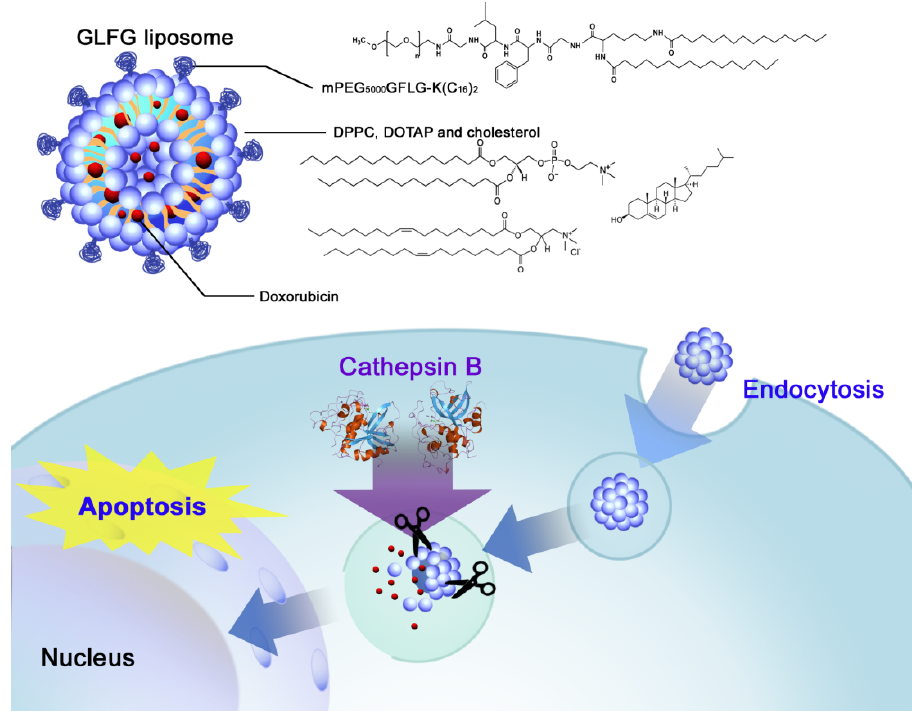
Figure 1. Schematic presentation of GLFG/Dox liposomes (doxorubicin loaded GLFG (Gly-Leu-Phe-Gly) liposomes) for enzyme-triggered drug delivery.